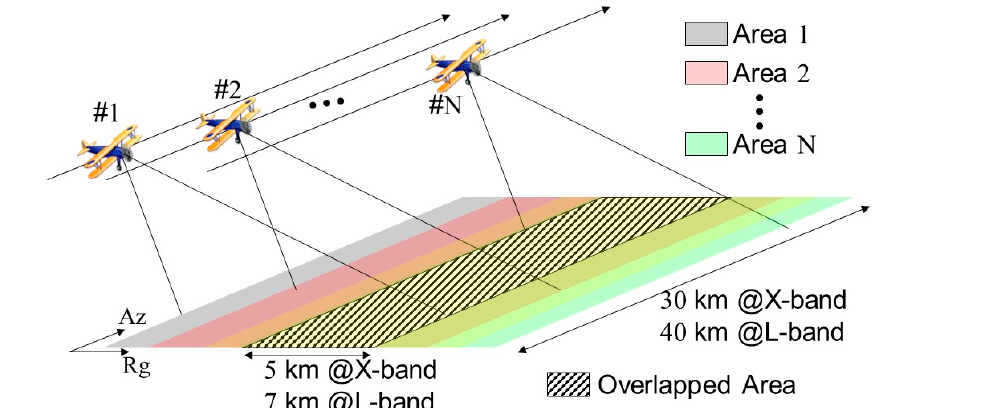
Figure 14. Concept of multi-incidence angle observation by an airborne synthetic aperture radar (SAR). Each orbit is gradually varied so that a specific point within the overlapped area has N sets of fully polarimetric data in terms of the incidence angle [36].